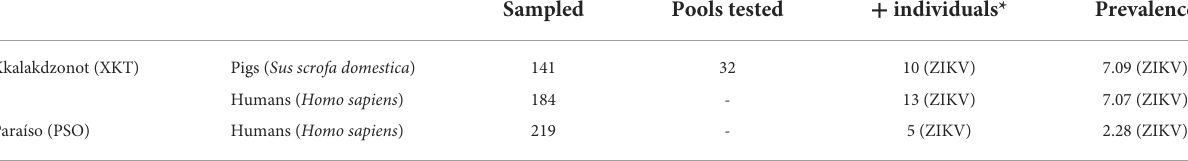
TABLE 3 Positive vertebrates and prevalence of infection in two Mayan communities of Yucatan, Mexico. Sampled Pools tested + individuals*